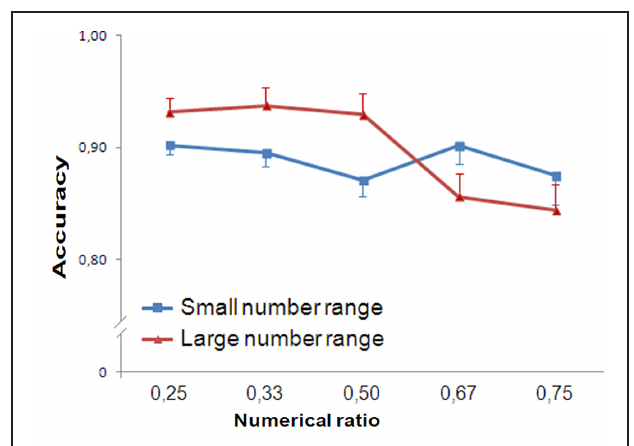
FIGURE 4 | Results of Experiment 3. Accuracy is plotted against the numerical ratio of the contrasts for both small and large number range. The performance of the participants showed ratio dependence for large numbers and ratio insensitivity in the subitizing range.